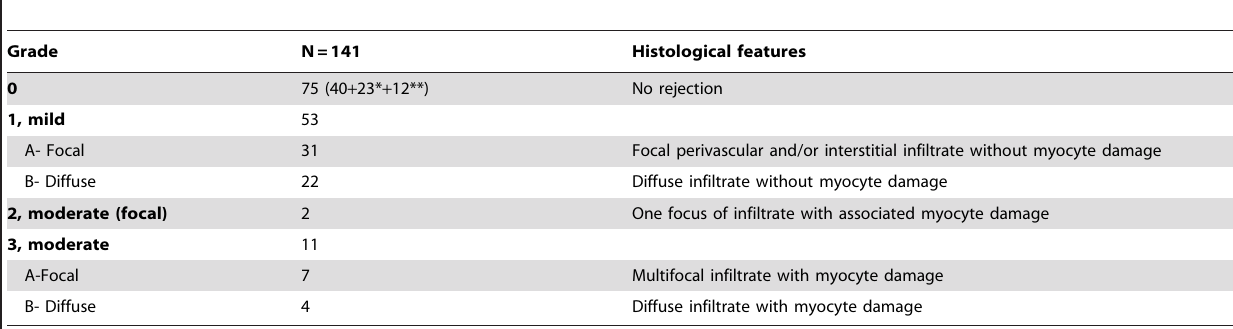
Table 1. 1990 ISHLT Standardized Cardiac Biopsy Grading Scheme for Acute Cellular Rejection and Corresponding Number of Samples Studied [18].